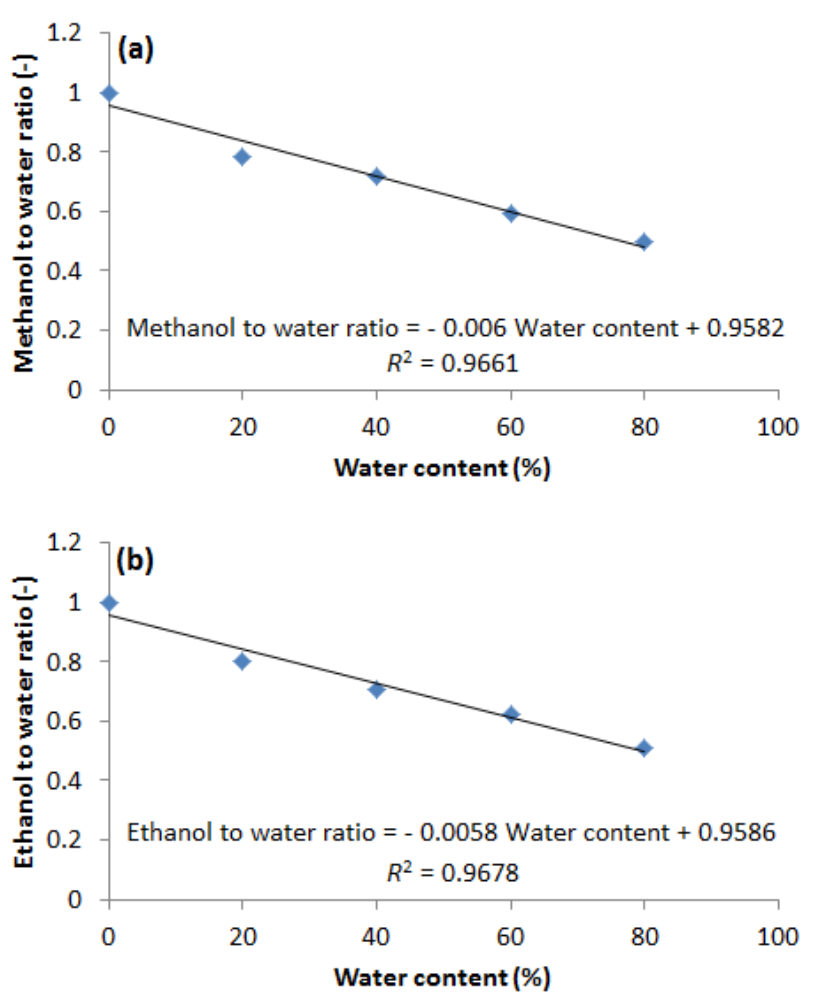
Figure 6. Dependency of the mass ratio of investigated fuels to water (evaporated from solution) in the combustion zone on the water content: ( a ) Dependency of the mass ratio of methanol to water (evaporated from solution) in the combustion zone on the water content; ( b ) Dependency of the mass ratio of ethanol to water (evaporated from solution) in the combustion zone on the water content. Table 1. Mass loss of fuel solutions from ignition to the spontaneous flame extinction.